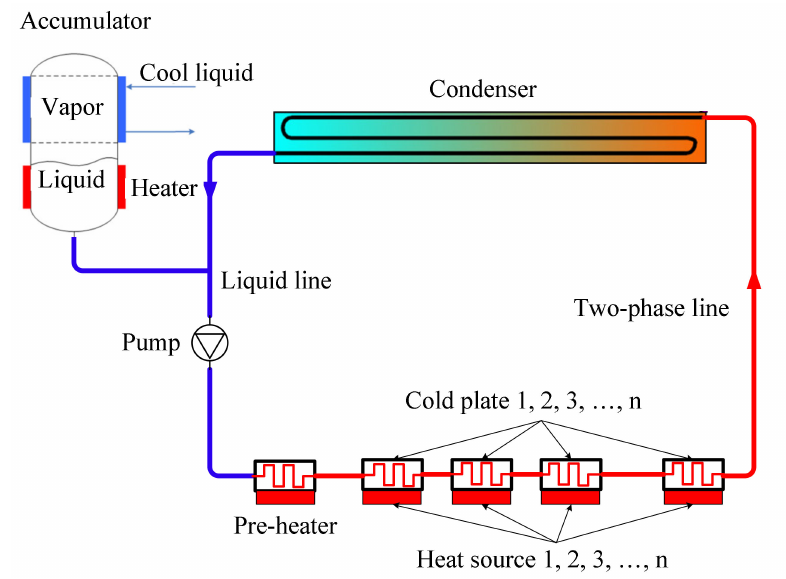
Figure 1. Schematic diagrams of an MPTL system for a space remote